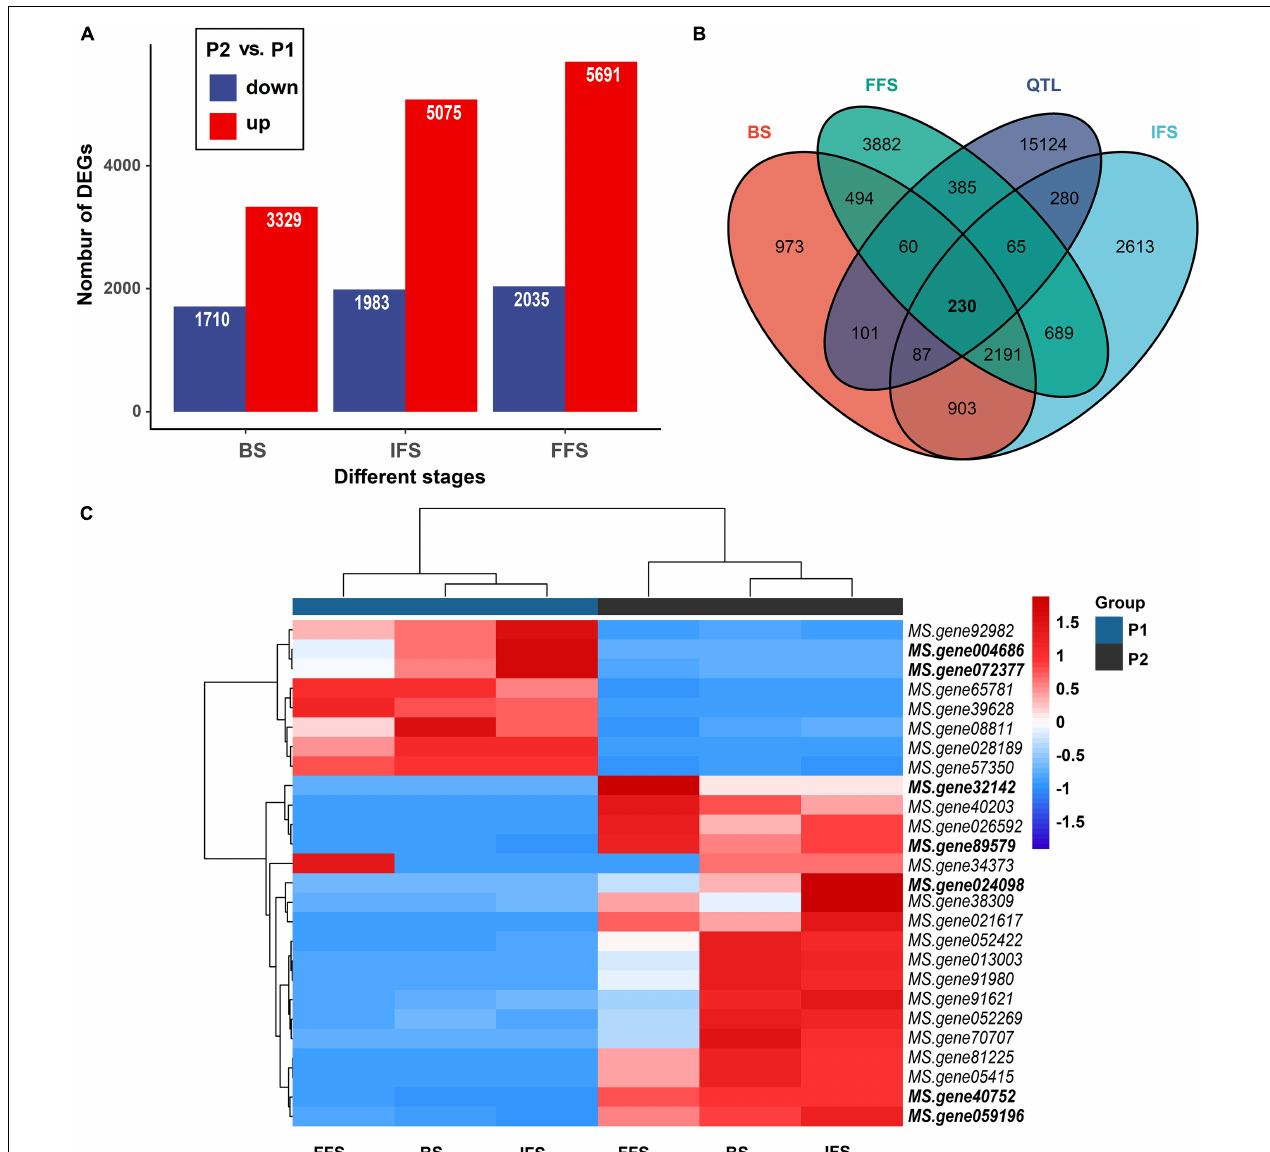
FIGURE 4 | Differentially expressed genes (DEGs) within QTL intervals. (A) Number of downregulated genes (blue) and upregulated genes (red) between two parents at three flowering stages. BS, budding stage, IFS, initial flowering stage and FFS, full flowering stage. (B) The number of DEGs within QTL intervals. (C) Heatmap clustering the DEGs associated with flowering time by their expression abundance. DEGs within the consistent QTL intervals or new environment-stable QTLs were